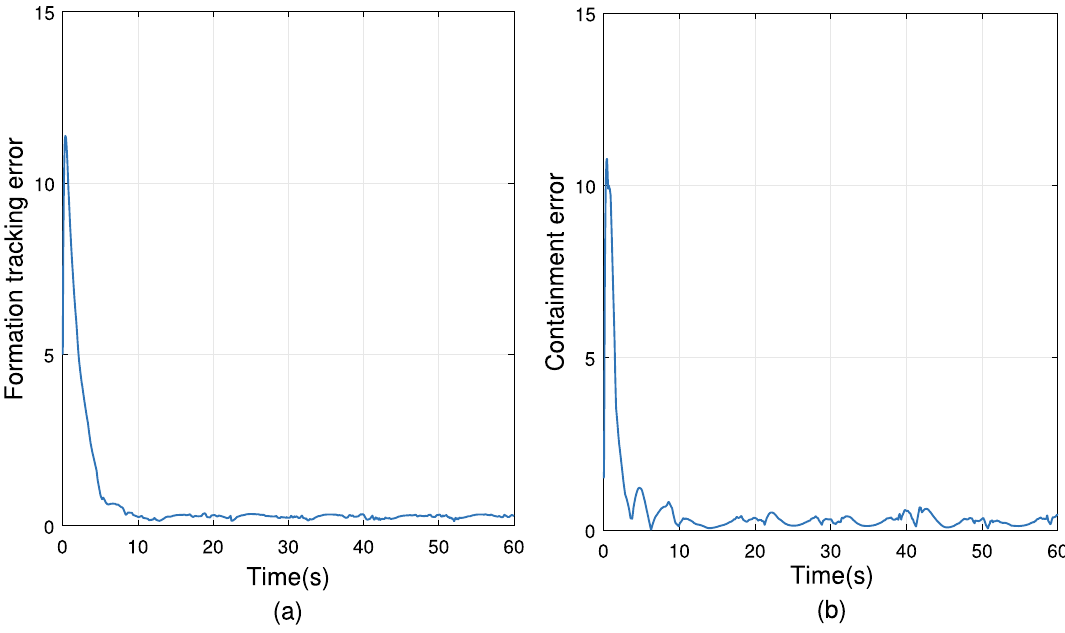
Figure 9. Curves of the formation tracking error for the leaders and the containment error for the followers. ( a ) Formation tracking error. ( b ) Containment